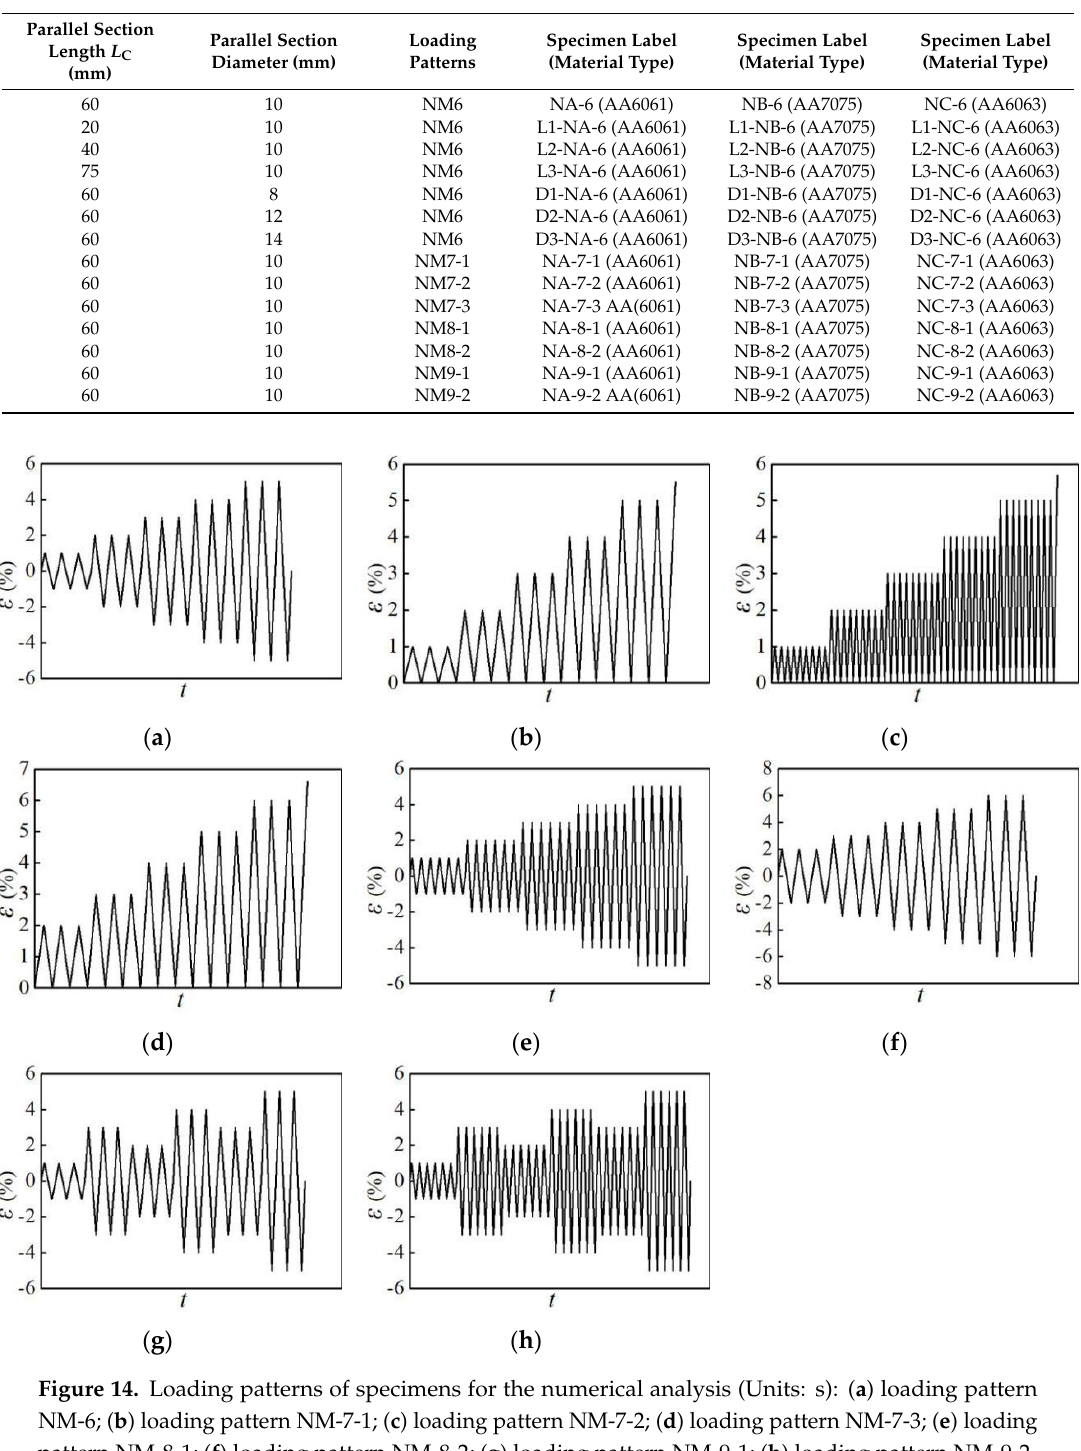
Table 3. Design of specimen for the numerical analysis.